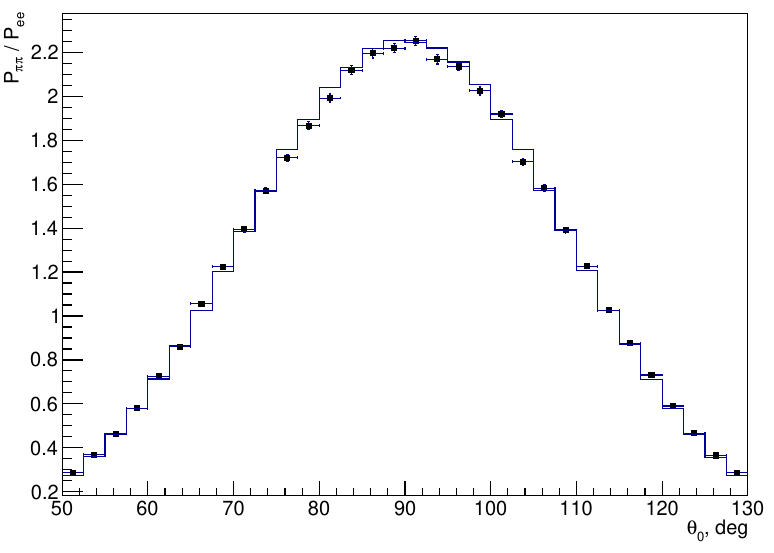
Figure 8 . The ratio of (cid:18) 0 distributions of e + e (cid:0) ! (cid:25) + (cid:25) (cid:0) and e + e (cid:0) ! e + e (cid:0) events. Histogram { simulation, dots {